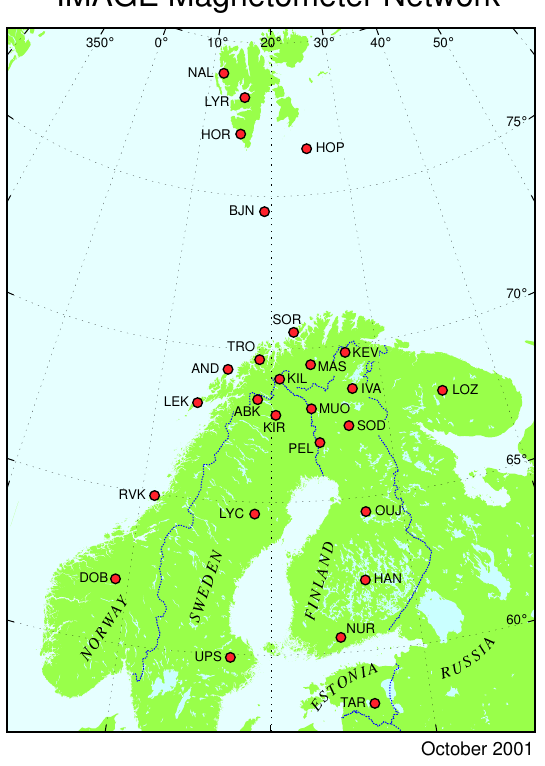
Fig. 2. Map showing the locations of IMAGE magnetometer sta- tions, the EISCAT facility is in Tromsø (TRO), and the all-sky cam- era in Kilpisj¨arvi